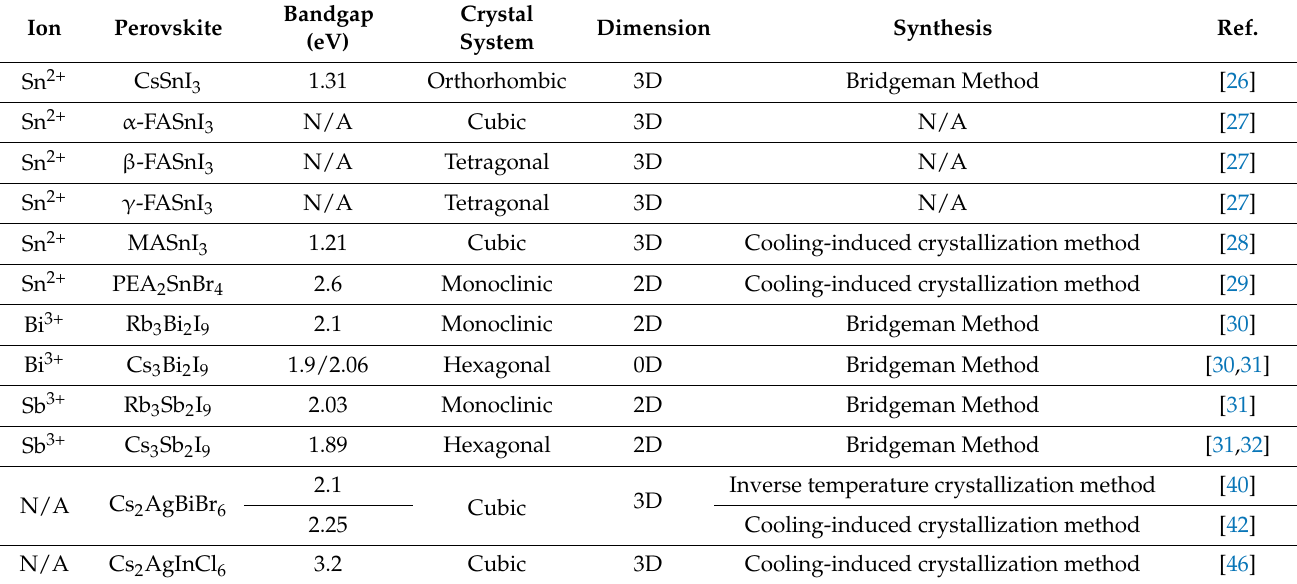
Table 1. Summary of structural parameters and synthesis methods of representative